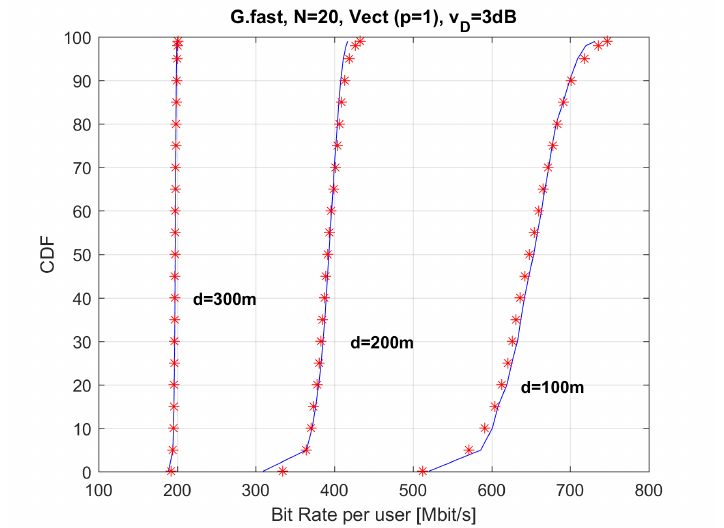
Figure 5. CDFs of the bit rate per user in the vectoring case ( p = 1) for G.fast: N = 20. Exact (solid) and Gaussian approximation (asterisks) results are